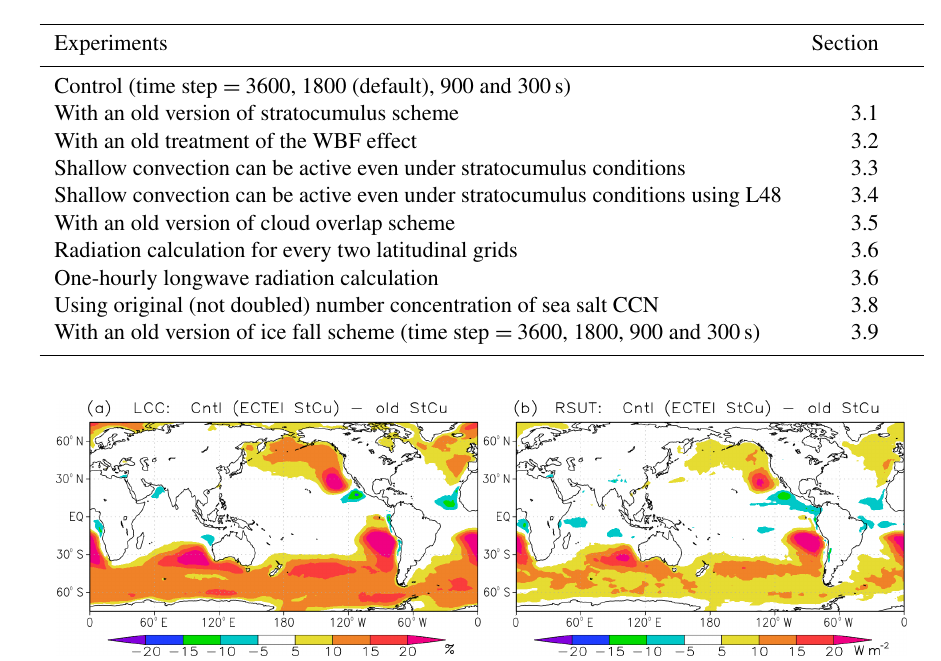
Table 1. List of sensitivity experiments performed in the present study using MRI-ESM2 to identify the effect of each modification. The second column shows the section in which each modification is discussed.